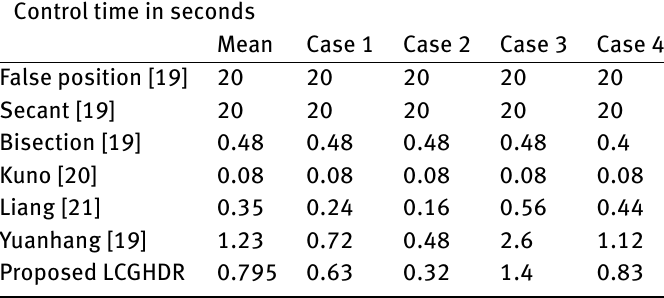
Table 6: Control time in seconds for several